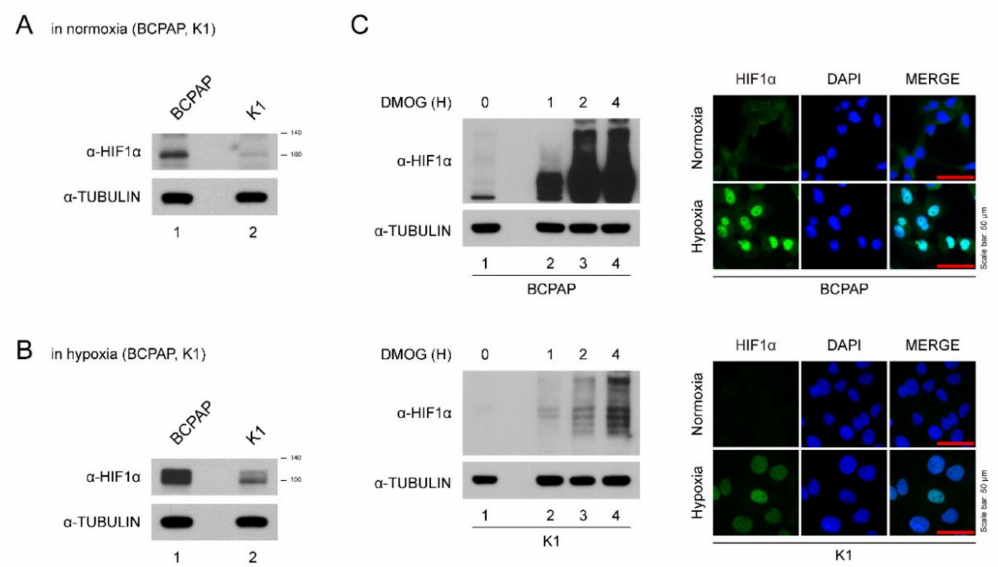
Figure 1. Expression of HIF-1 α in thyroid cancer lines. ( A ) HIF-1 α expression levels in di ff erent thyroid cancer cells under normoxia. Thyroid cancer cells (BCPAP and K1) were seeded and incubated in normoxic conditions. Cell lysates were immunoblotted with anti-HIF1 α and anti-TUBULIN. ( B ) HIF-1 α expression levels in di ff erent thyroid cancer cells under hypoxia (with DMOG for 4 h). Thyroid cancer cells (BCPAP and K1) were seeded and incubated in hypoxic conditions. Cell lysates were immunoblotted with anti-HIF1 α and anti-TUBULIN. ( C ) Western blotting and immunofluorescence analysis of HIF-1 α expression of BCPAP and K1 cells after DMOG treatment. (Left) Western blot analysis of HIF1 α protein in hypoxia condition. BCPAP and K1 cells were seeded and treated with DMOG at indicated time point. Cell lysates were immunoblotted with anti-HIF1 α and anti-TUBULIN. (Right) Immunofluorescence analysis of HIF1 α protein under normoxia or hypoxia. BCPAP and K1 cells were stained with HIF1 α antibody. Nuclei were counterstained with DAPI. Scale bar represents 50 µ m (100 ×